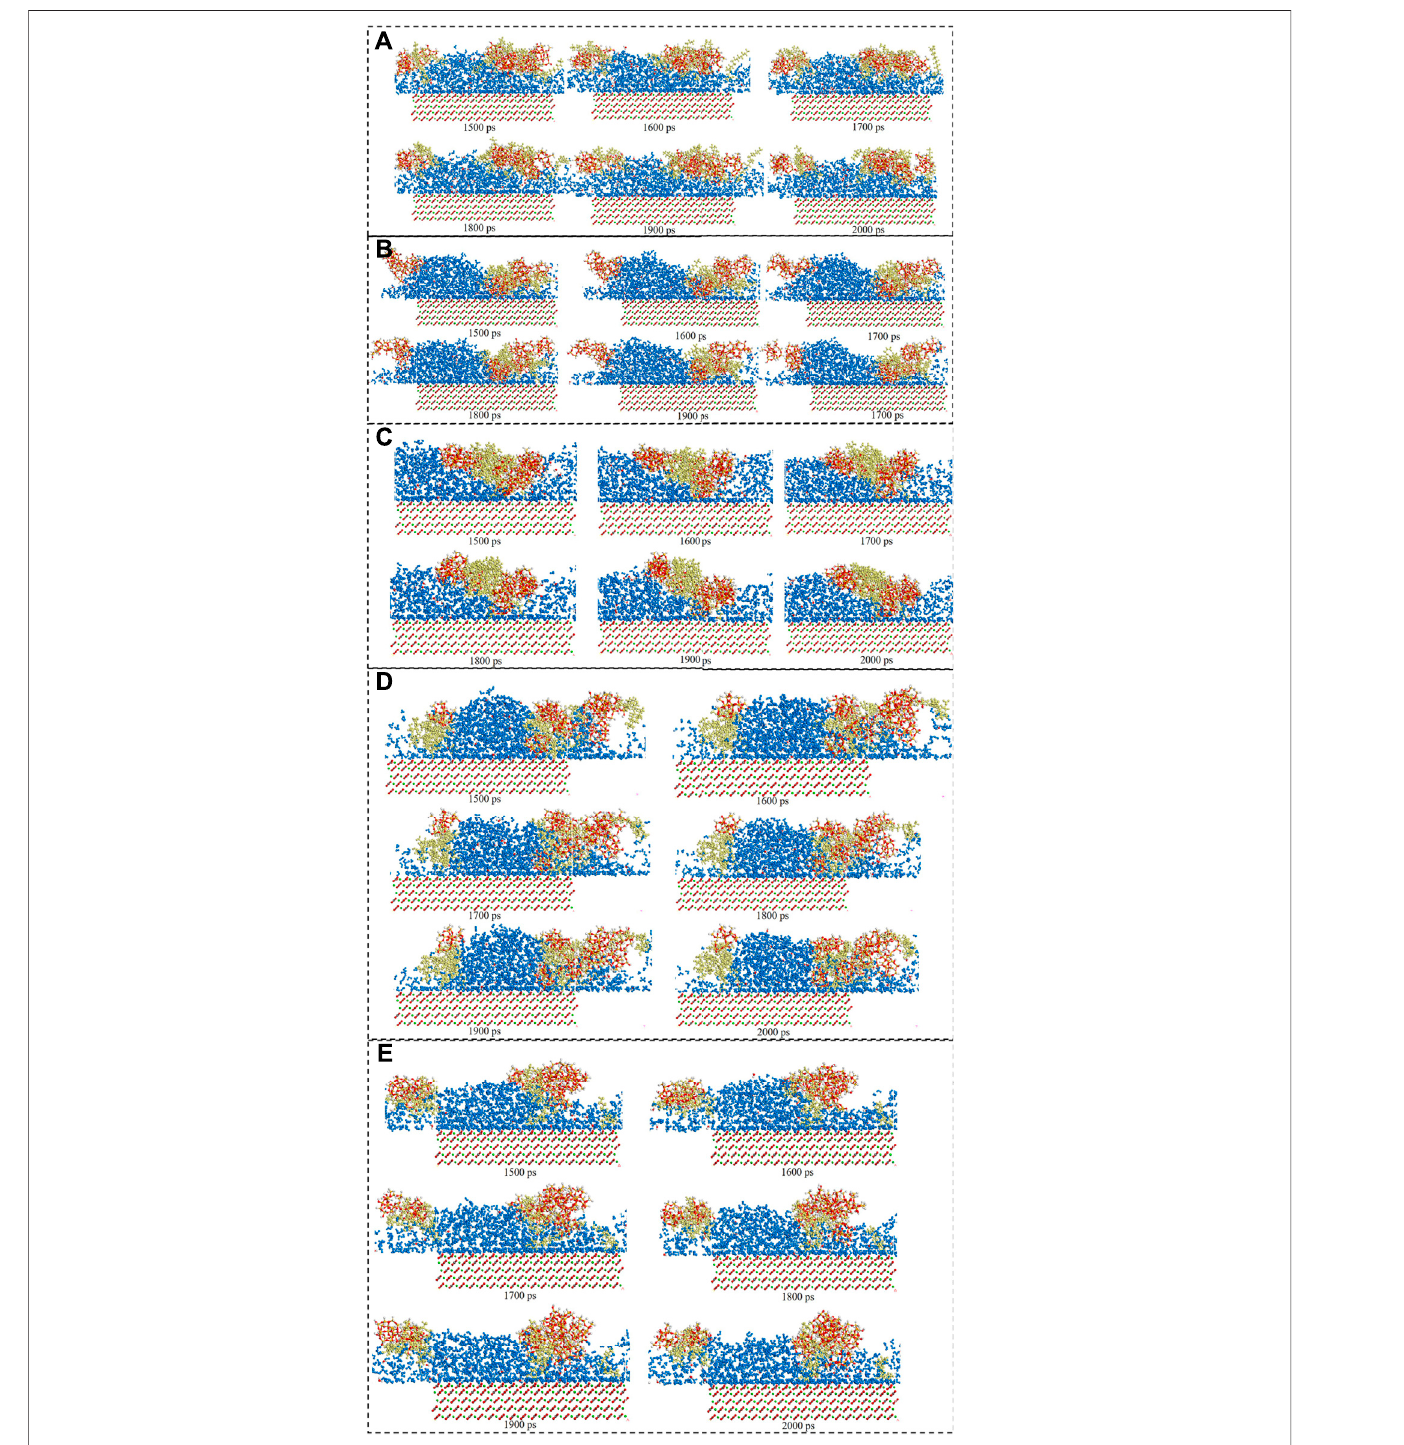
FIGURE10| Consecutive snapshot(1,500 – 2000 ps)of (A) CTAB-SiO 2 , (B) SDS-SiO 2 , (C) TX-100-SiO 2 , (D) Sophorolipid-SiO 2 , (E) Rhamnolipid-SiO 2 adsorption onto the modelled calcite surface. yellow = surfactants, red and grey = CO 32 − , green = Ca 2+ , red, grey and green = calcite surface, red and white = SiO 2 nanoparticles.